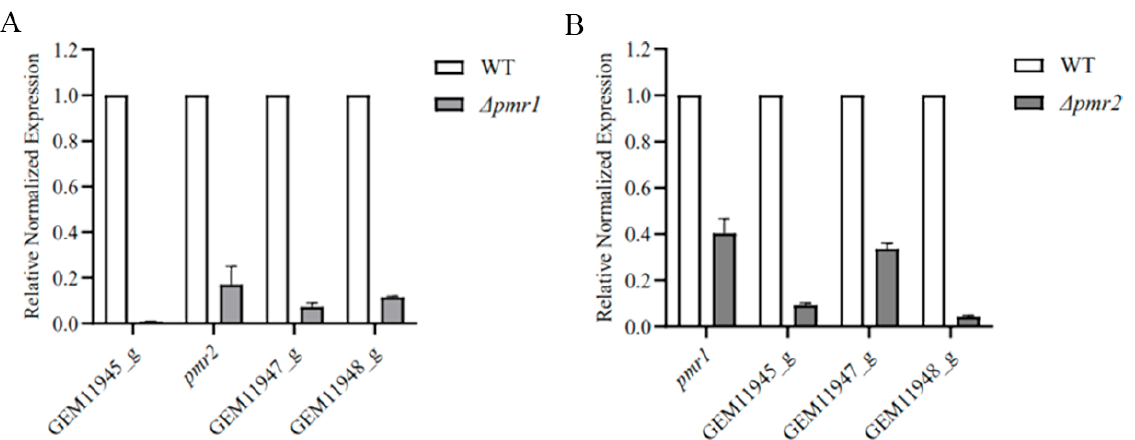
Figure 6. Pmr1 and Pmr2 positively regulates the expression of genes related to melanin synthesis. ( A ) RT-qPCR analysis of other genes in melanin synthetic gene cluster in Δ pmr1 strain grown in PLB for 7 days. The expression data were analyzed by the GraphPad 8. The gene expression quantity of wild type was standardization to ‘1’. ( B ) RT-qPCR studies on transcription levels of other genes in melanin synthetic gene cluster in ∆ pmr2 strain grown in PLB for 7 days. The expression data were analyzed by the GraphPad